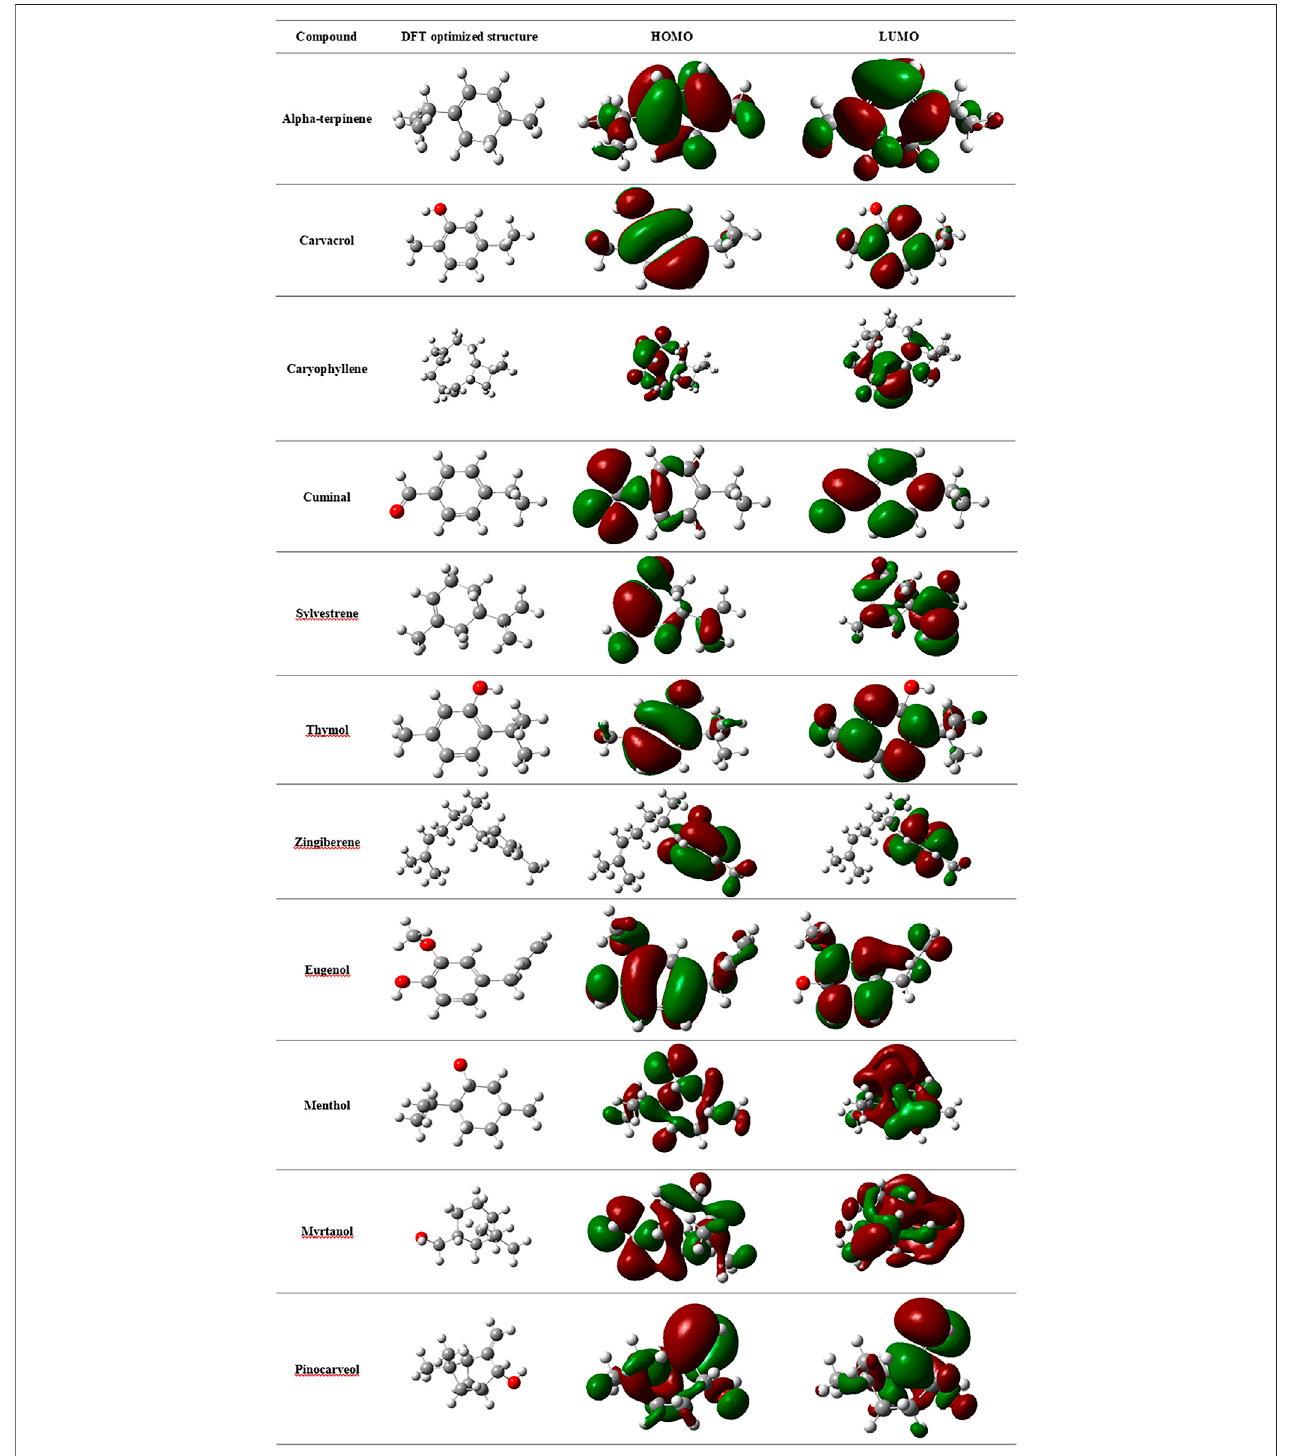
FIGURE 4 | Electron density maps of the HOMO and LUMO of selected essential oil